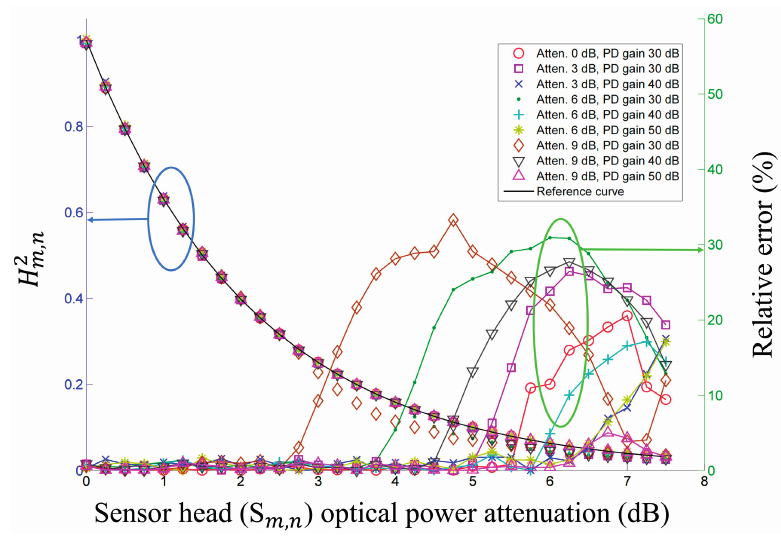
Figure 2. Measured (cid:1834) (cid:3040),(cid:3041)(cid:2870) (left) and relative error (right) versus sensor head optical power attenuation with various source optical power attenuations and PD gains.